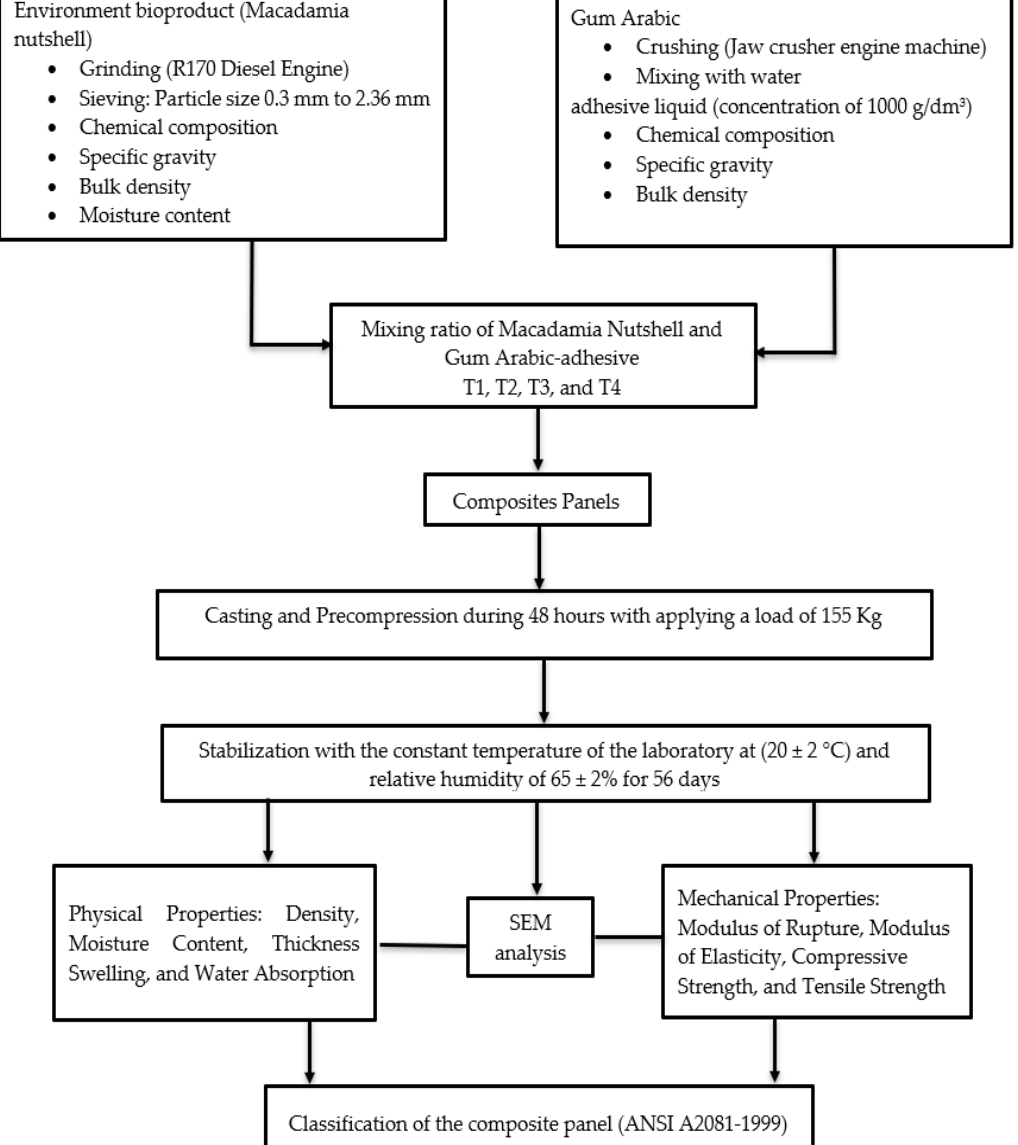
Figure 6. Flowchart used in the present study.